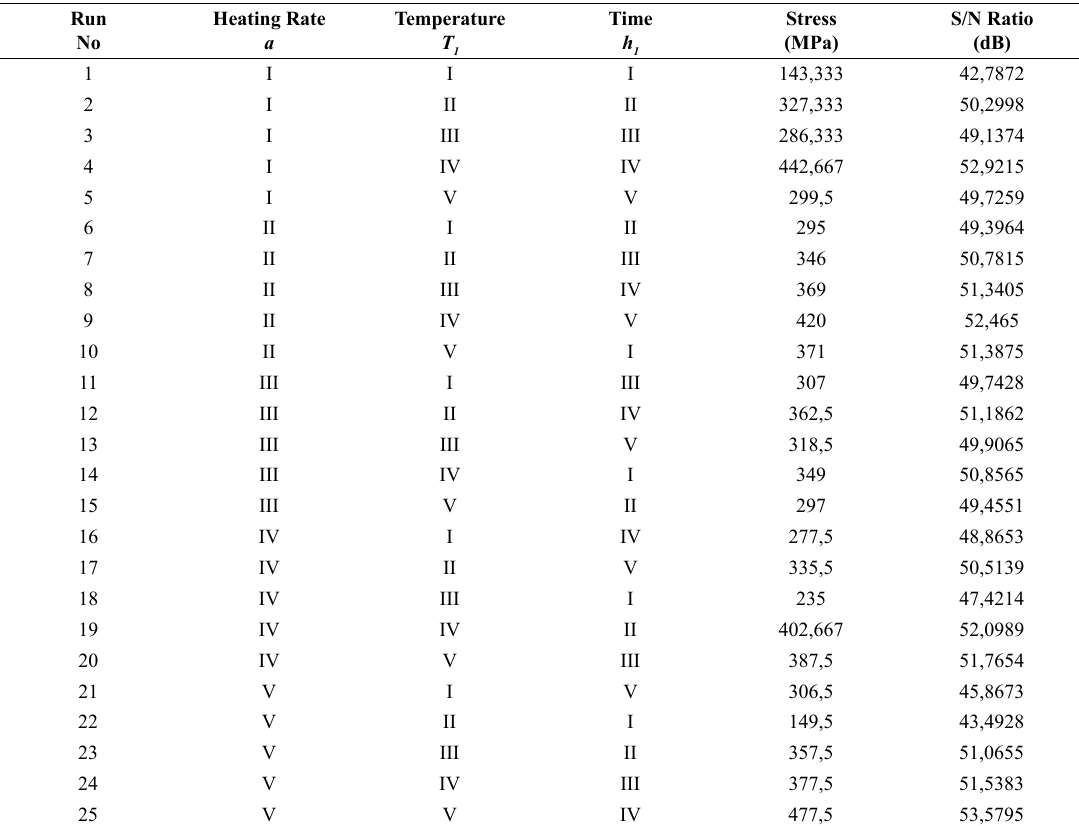
OA response values a nd S/N ratio for Stress in Flexural tests. Table 4. Taguchi L 25